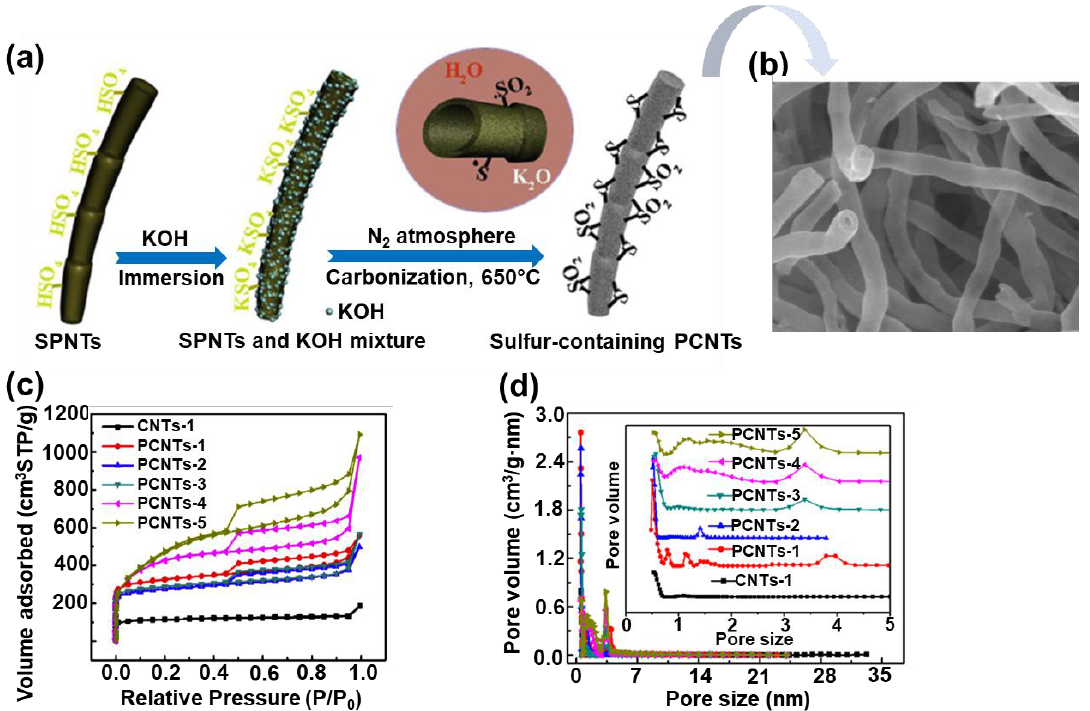
Figure 8. ( a ) Schematic illustration of synthesis of sulfur-containing porous carbon nanotubes (PCNTs). ( b ) SEM images of PCNT sample with sulfur content of about 3% (PCNTs-3), ( c ) nitrogen adsorption isotherms of PCNT samples, ( d ) pore size distributions determined for PCNT samples. Reproduced with permission from ref. [81]. Copyright 2017, Elsevier